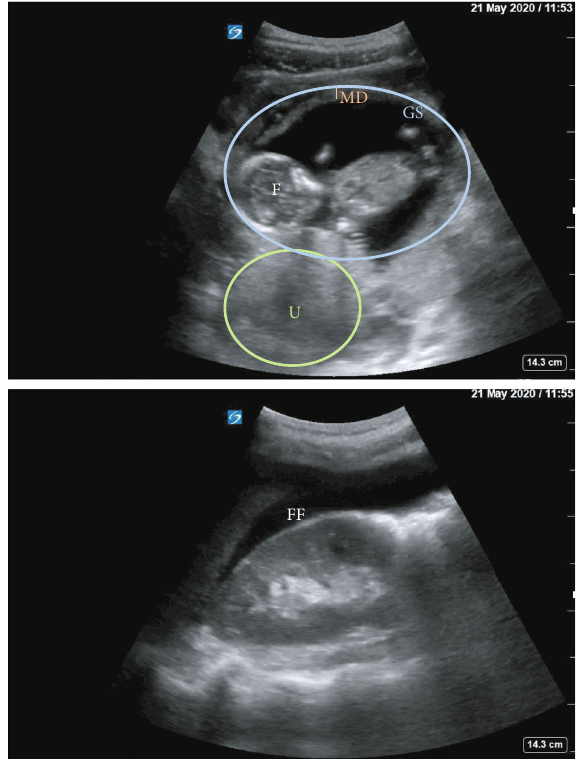
Figure 3: Bedside TAUS on visit 3. MD =mantle distance; GS =gestational sac; F=fetus; U=uterus; FF =free fl uid around the liver tip.